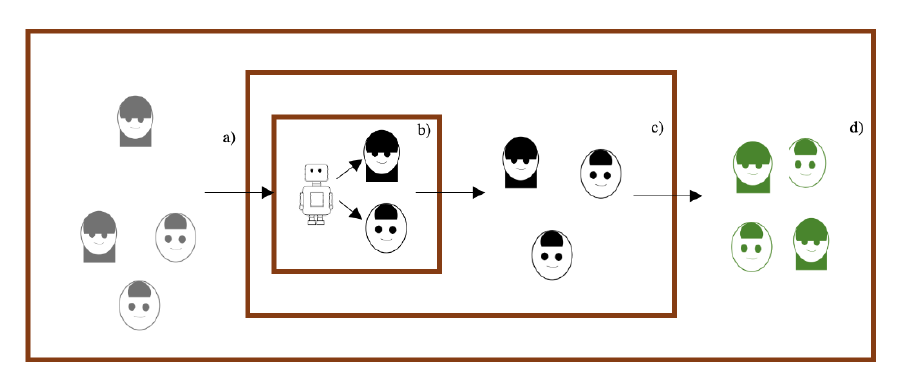
Figure 3. Schematic representation of the levels of analysis of HRI in groups: ( a ) group composition (e.g., size, individual characteristics of the members of the group), ( b ) direct interaction among robot(s) and members of the group, ( c ) indirect interaction among robot(s) and members of one group and members of another group and ( d ) interaction between mixed groups of humans and robots (which might have interacted directly or indirectly), and the wider society. The arrows represent unidirectional interactions. Please note that the gender distribution and colors implied by the icons is not significant, and was added to symbolize diversity within each